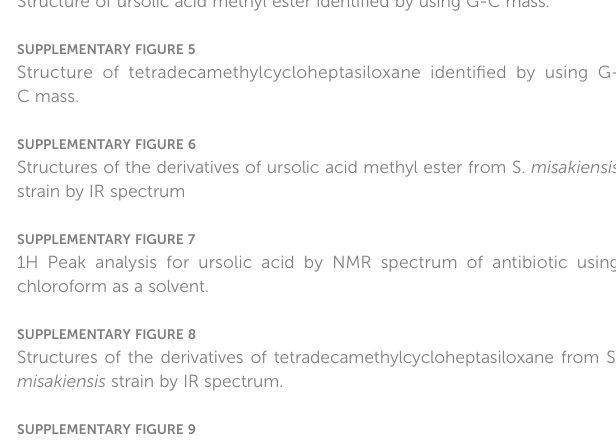
SUPPLEMENTARY FIGURE 3 Structureofursolicacidmethylesterandtetradecamethylcycloheptasiloxane characterized by using HPLC-preparative and G-C mass.